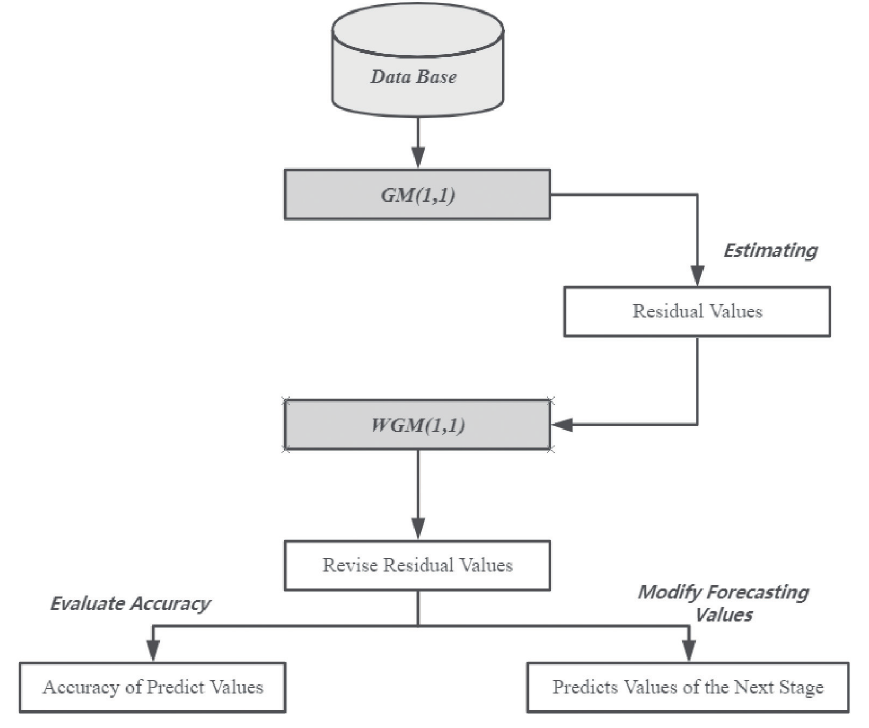
Fig 1. Flow chart of